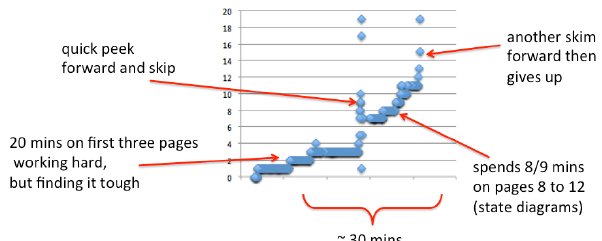
Figure 3. Individual student trace through document: complex behaviour: both detailed